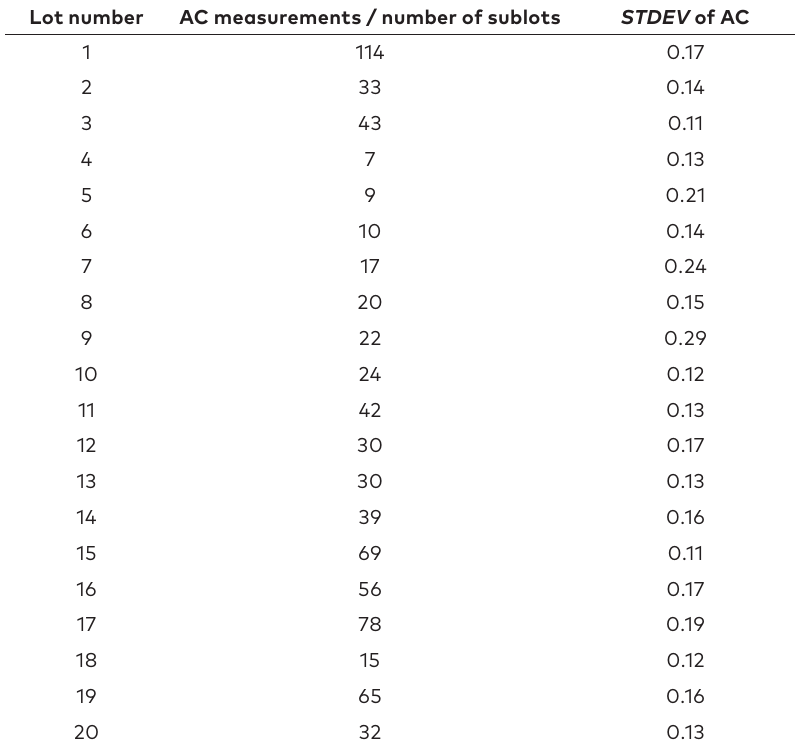
Table 1. STDEV values of AC from 20